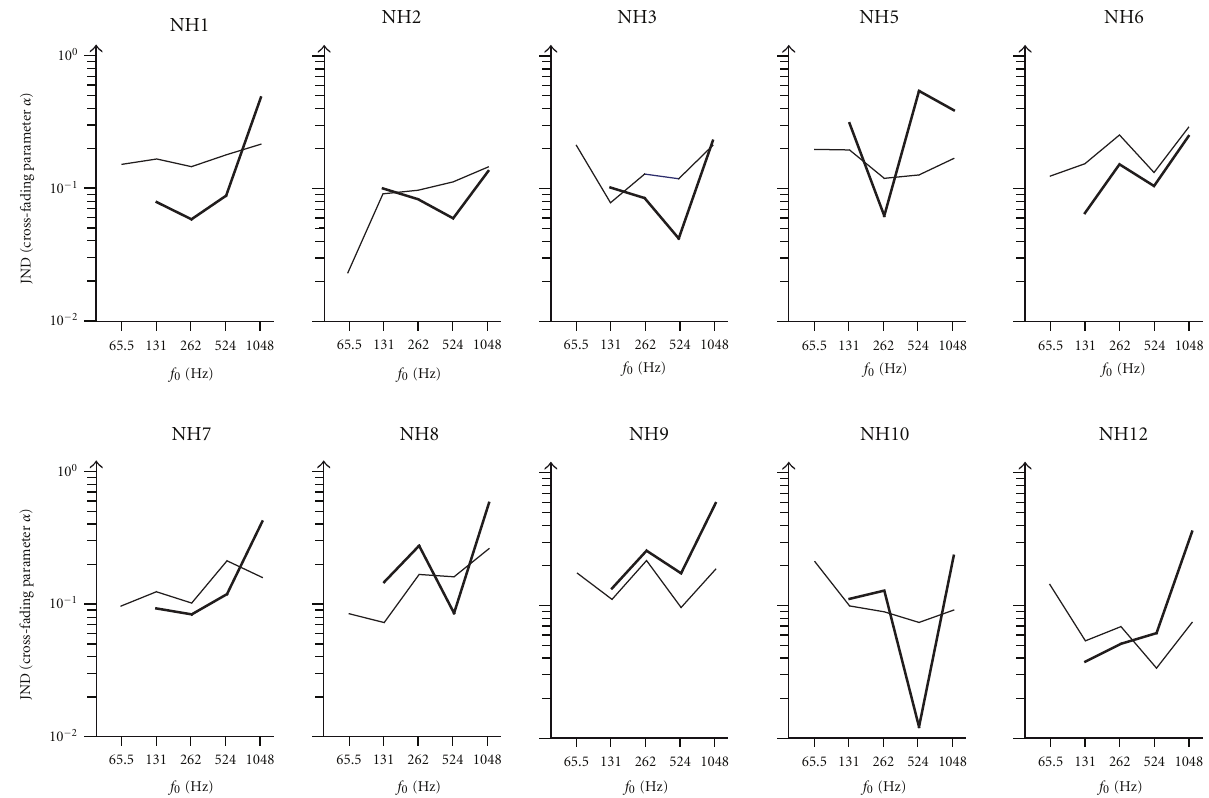
Figure 3: Individual spectral shape JND for the stimulus conditions of f 0 = 65 . 6Hz, 131Hz, 262Hz, 524Hz, and 1048Hz as revealed by the normal hearing participants using a Baha (thick line) or not (thin line). Using the Baha, the resulting JND is poorer in the f 0 = 1048Hz condition and no JND could be measured in the f 0 = 65 . 6Hz